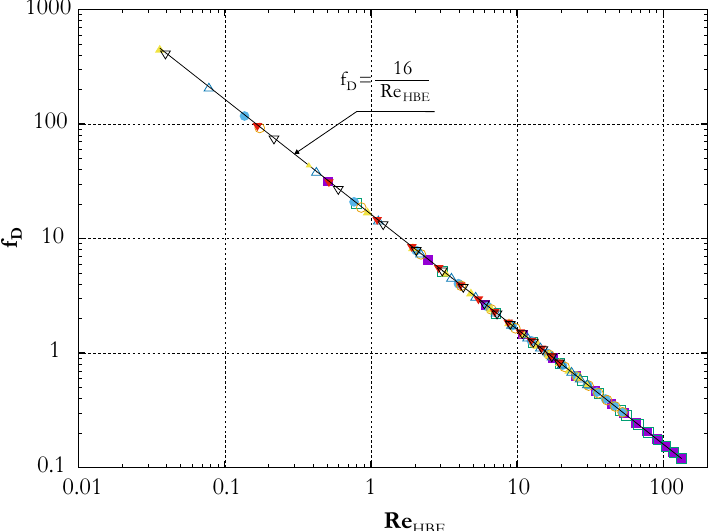
Figure 4. Blasius plot f D = f ( Re HBE ) prepared on the base of rheological data obtained during flow experiment in capillary-pipe viscometer for xanthan gum solutions (0.25–1.00%) at the measurement temperature 21 °C. The values od Reynolds number and friction coefficients were calculated according to Equations (6) and